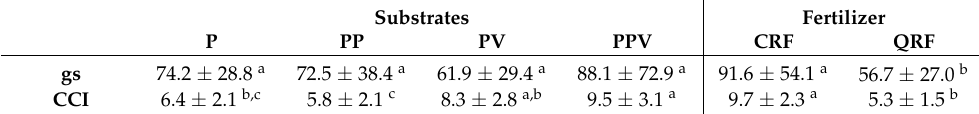
Table 1. Effect of substrates (P: peat; PP: peat with perlite; PV: peat with vermiculite; PPV: peat with perlite and vermiculite—without distinguishing between fertilizers); and the effect of controlled-release (CRF) and quick-release (QRF) fertilizers (without distinguishing between substrates), on stomatal